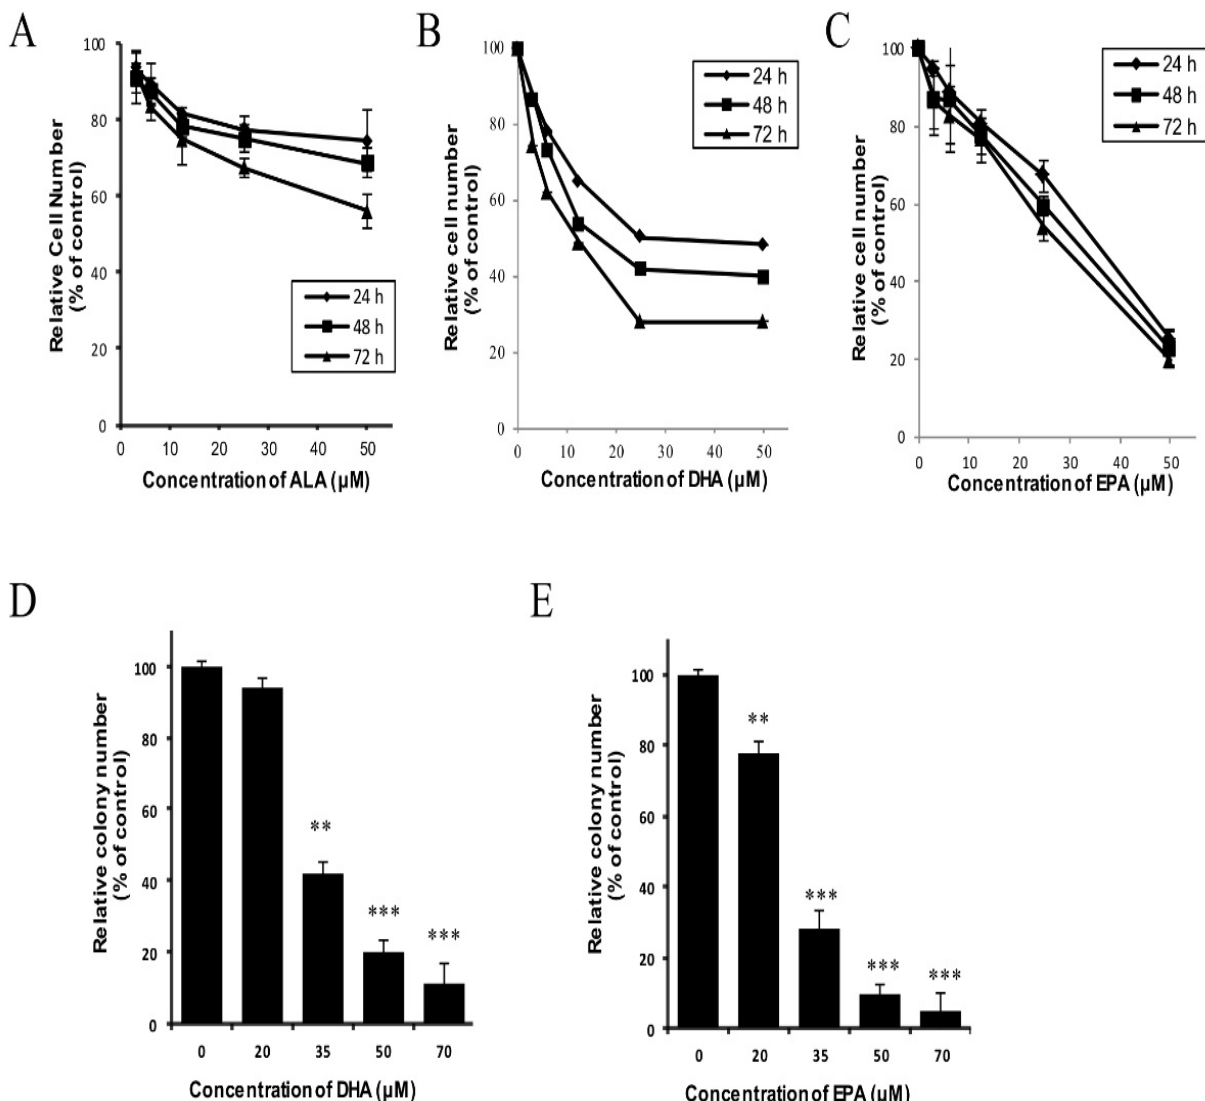
Figure 1. Growth-inhibitory effects of ALA, DHA and EPA on the human neuroblastoma LA-N-1 cells. ( A – C ) LA-N-1 cells were incubated with various concentrations of ALA ( A ), DHA ( B ) or EPA ( C ) for 24 hours, 48 hours or 72 hours. Cells treated with 0.5% ethanol